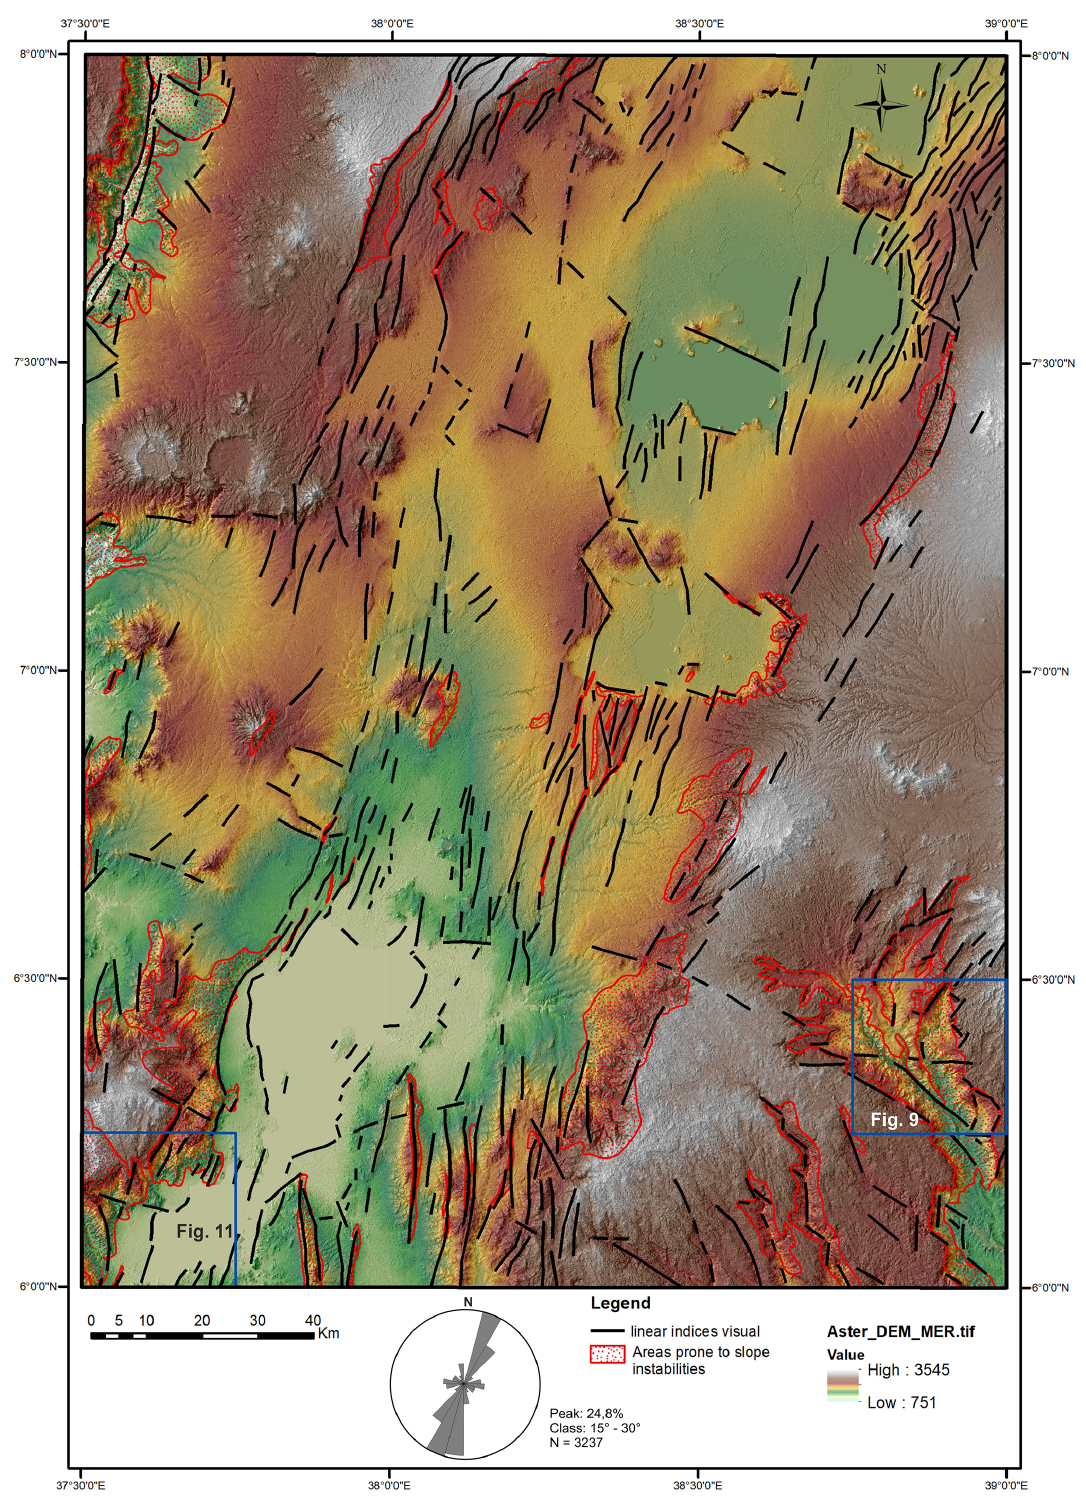
Figure 2. DEM (colour elevation map on multidirectional shaded relief) of the Dilla and Hossana areas, with visually interpreted linear indices and the distribution of their strikes in a rose diagram. The locations of the Mejo (Fig. 9) and Arba Minch (Fig. 11) detailed study areas are also shown (see Sect. 4.5). Digital elevation models ASTER DEM and SRTM3, with a resolution of 30m, were used (USGS EROS Archive; NASA LP